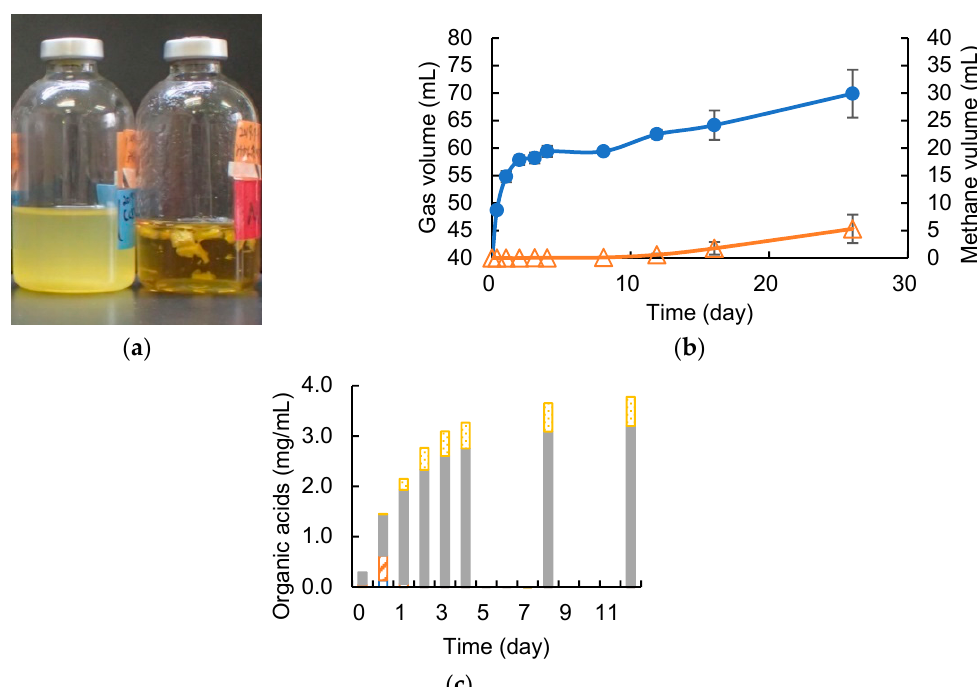
Figure 5. ( a ) CCeM culture (left), negative control (right); ( b ) time course of gas production, where total gas volume ( ● _closed circle) and methane volume ( Δ _open triangle) are included; ( c ) time course of organic acids concentration of CCeM, where lactic acid (closed bars), formic acid (open bars), acetic acid (closed bars), and propionic acid (dotted bars) are included. Values with error bars are mean ± SE of three independent samples. SE means a standard error. An asterisk indicates a significant difference ( p < 0.05).